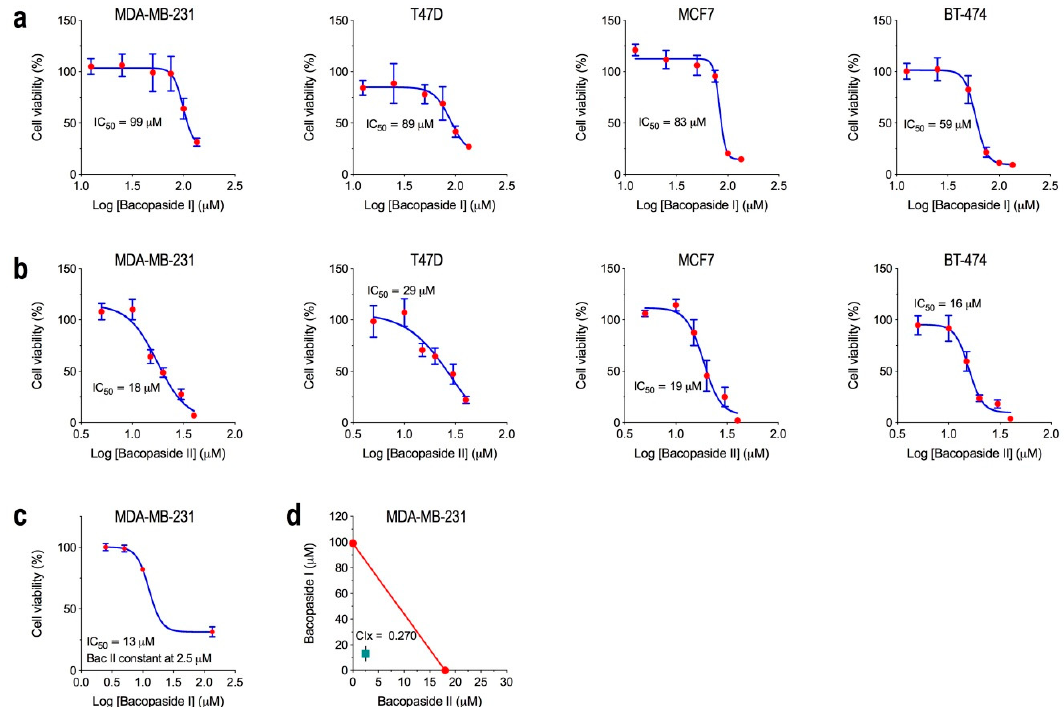
Figure 1. The IC 50 for Bac I and Bac II in breast cancer cell lines. Breast cancer cell lines were treated with different doses of bac I or bac II and their cell viability determined by MTS assay. Data are the mean ± SD of six replicates from a representative experiment normalised to the vehicle control for bac I ( a ) and bac II ( b ). Non-linear regression analysis for bac I and bac II were used to calculate IC50 values for each drug. Relationships to the vehicle control were determined by one-way ANOVA with Bonferroni test. Regarding the synergy of bac I and bac II for MDA-MB-231 ( c ), cells were treated with varying doses of bac I combined with a constant dose of bac II (2.5 µ M) for 24 h. Data are the mean ± SD of six replicates normalised to the vehicle control, with IC50 determined by non-linear regression analysis. The IC50s for each drug used individually ( d ) were plotted as an isobologram (red theoretical line) for MDA-MB-231. The IC50 combination of bac I and II was also plotted, with the 95% CI represented by the black line.